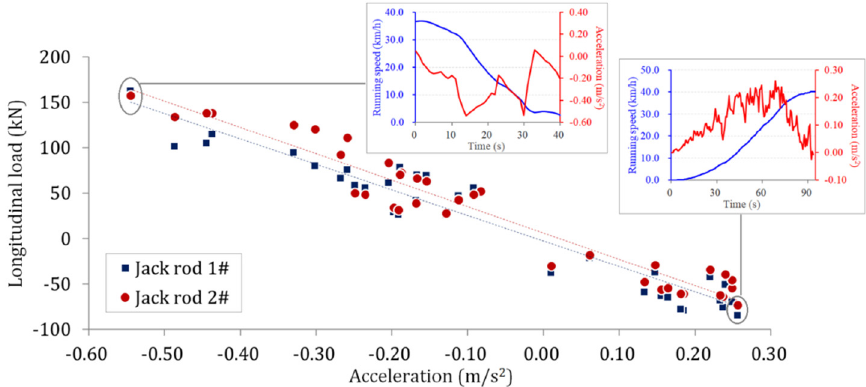
Figure 16: Mechanical relation between longitudinal load and running acceleration.